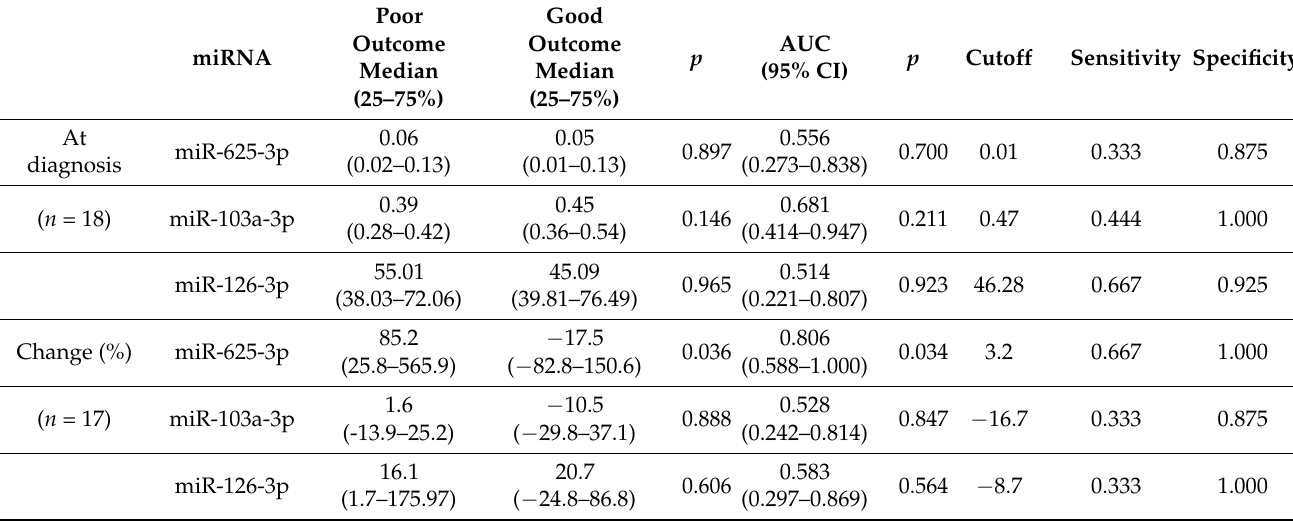
Table 3. Expression of serum EV-enriched miRNAs and treatment outcome of malignant mesothelioma patients and ROC curve